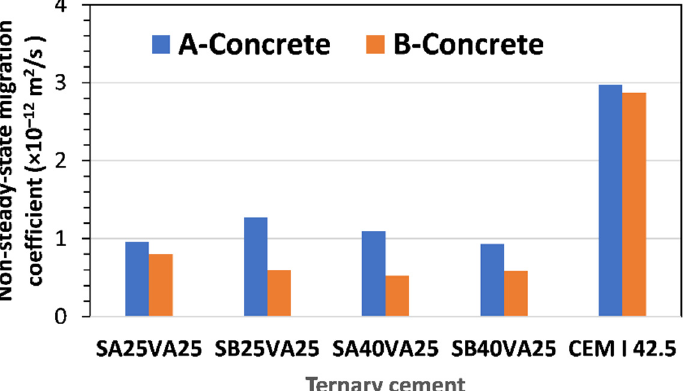
Figure 7. Non-steady-state migration coefficient (D nssm × 10 − 12 m 2 /s) determined according to the NT BUILD 492 standard.